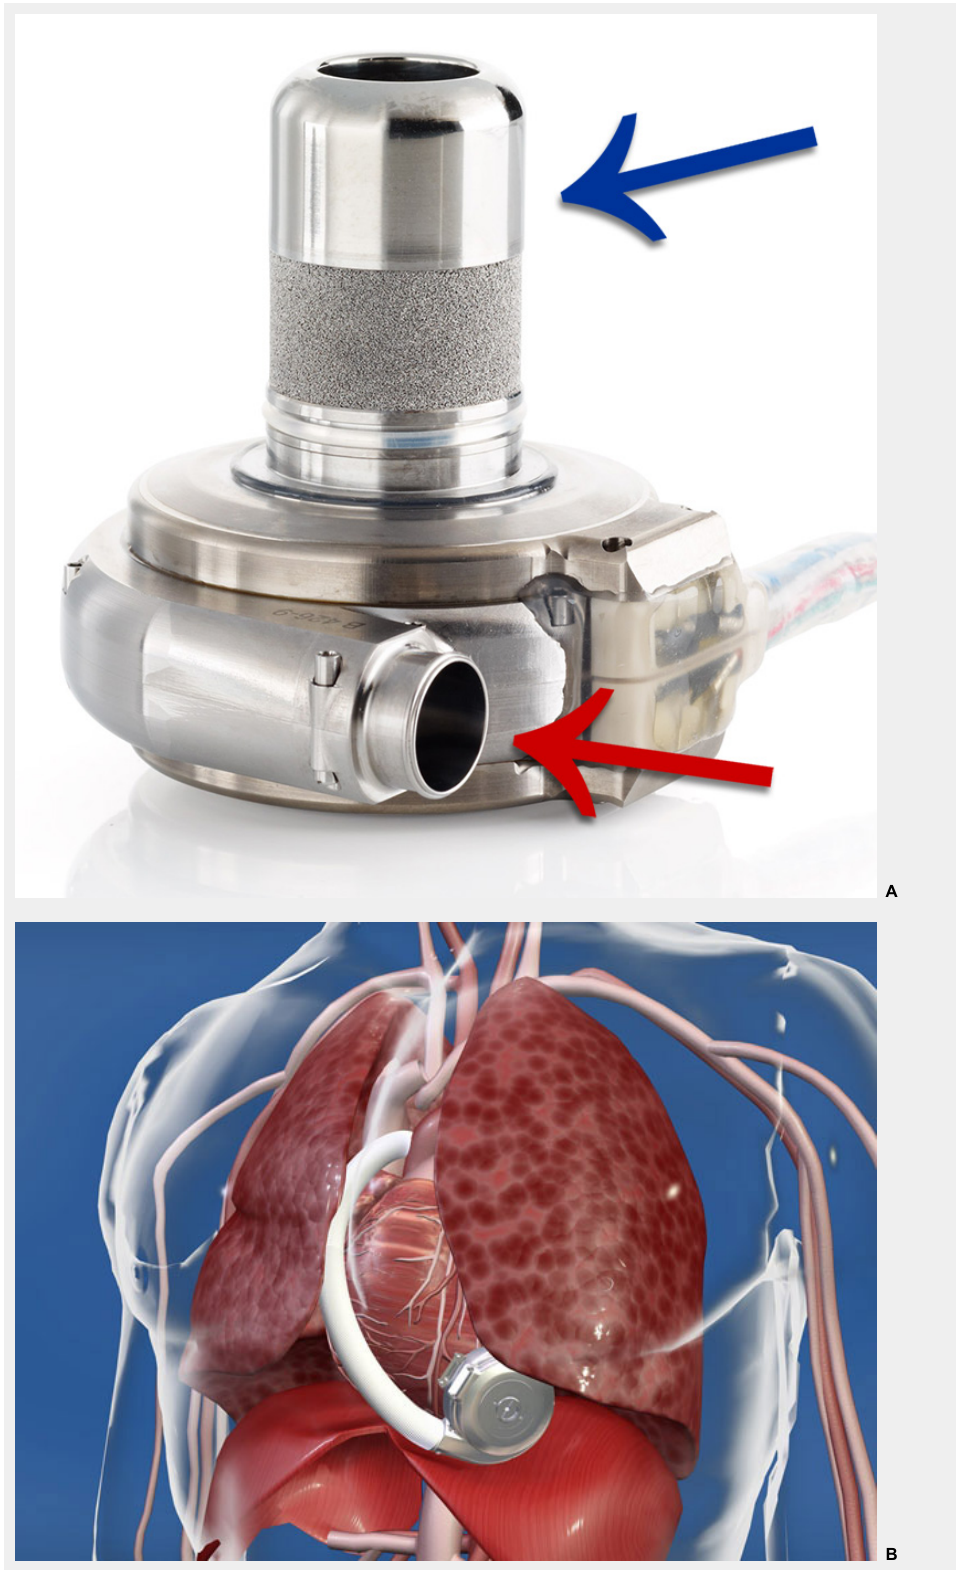
Figure 3: A: The HeartWare LVAD device with the tip of the device to be inserted into the LV apex (blue arrow) and the exit of the pump to be connected to the vascular prosthesis (ascending aorta; red arrow) (HVAD ® pump. © HeartWare. Reprinted with permission). B: In situ position of the device in the thoracic cavity (HVAD® pump in pericardial space. © HeartWare. Reprinted with